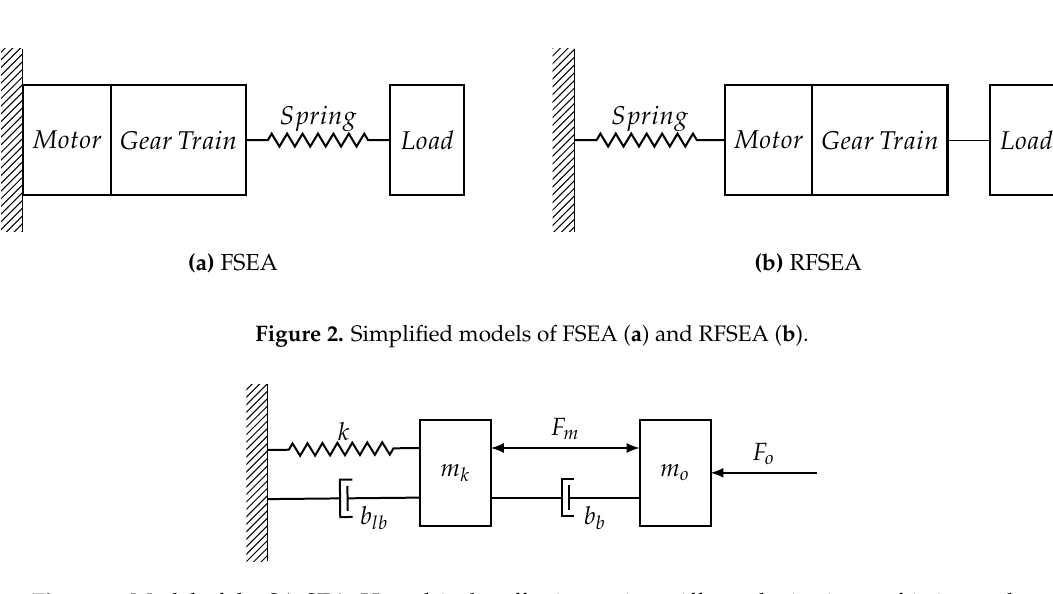
Figure 3. Model of the SA-SEA. Here, k is the effective spring stiffness, b lb is viscous friction at the linear ball bearings supporting the spring cage, m k is the total sprung mass of the actuator, F m is the motor force, b b is the viscous back-drive friction of the ball-screw mechanism, m o is the output mass and F o is the output